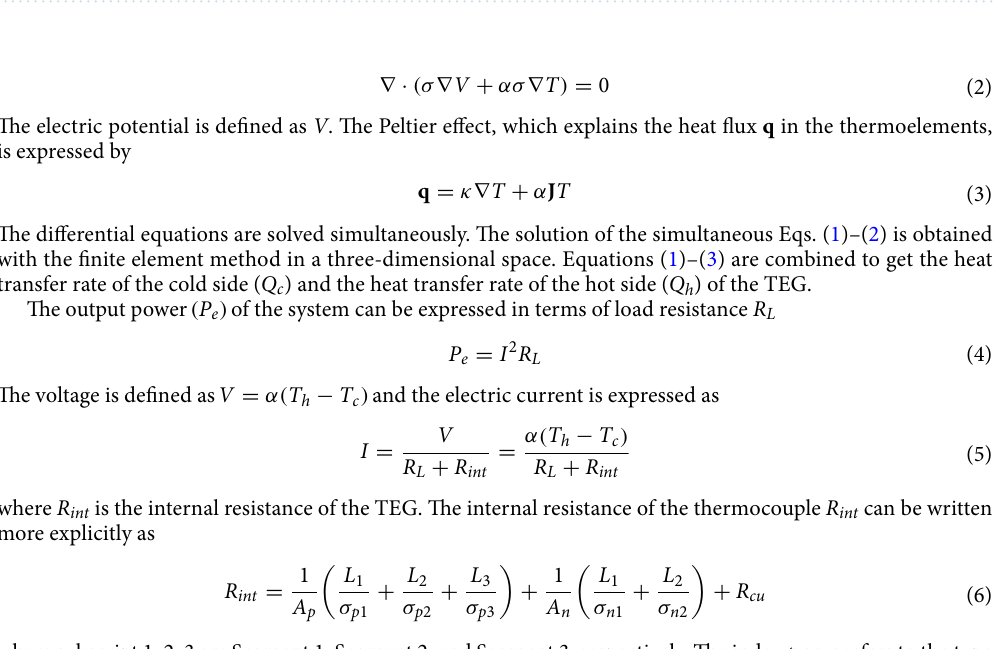
Figure 1. Micro segmented thermoelectric generator